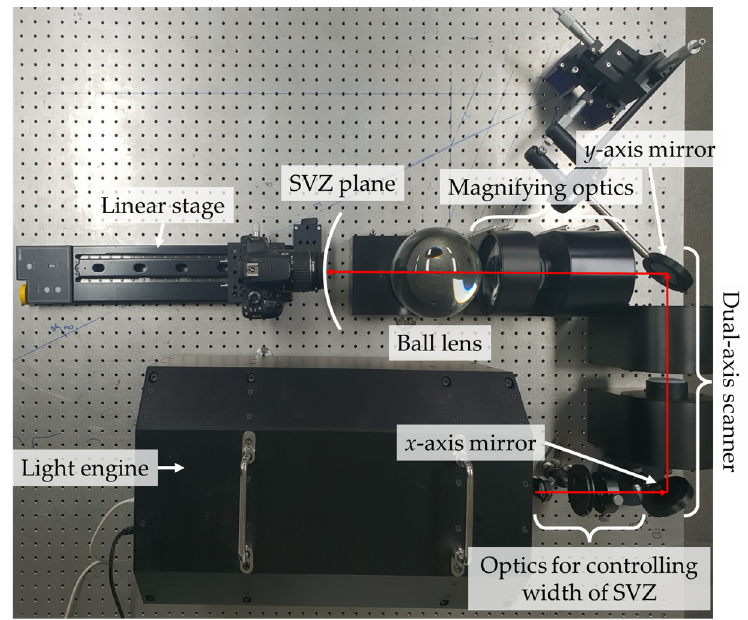
Figure 6 . Experimental setup for observation analysis. Figure 6. Experimental setup for observation analysis.